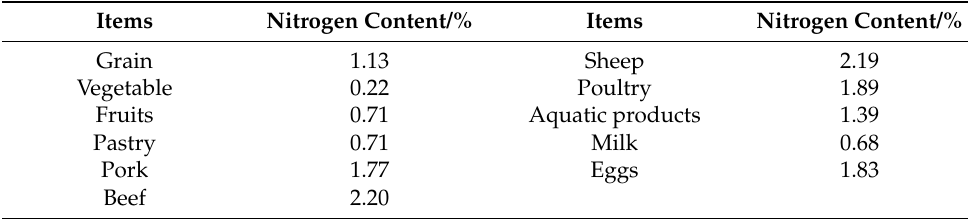
Table 3. The nitrogen conversion coefficients of household food consumption 1